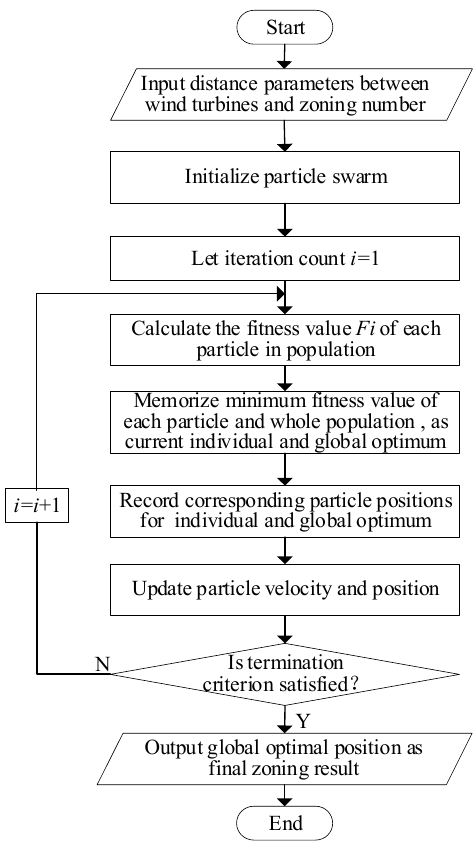
Figure 1. Improved DPSO algorithm.